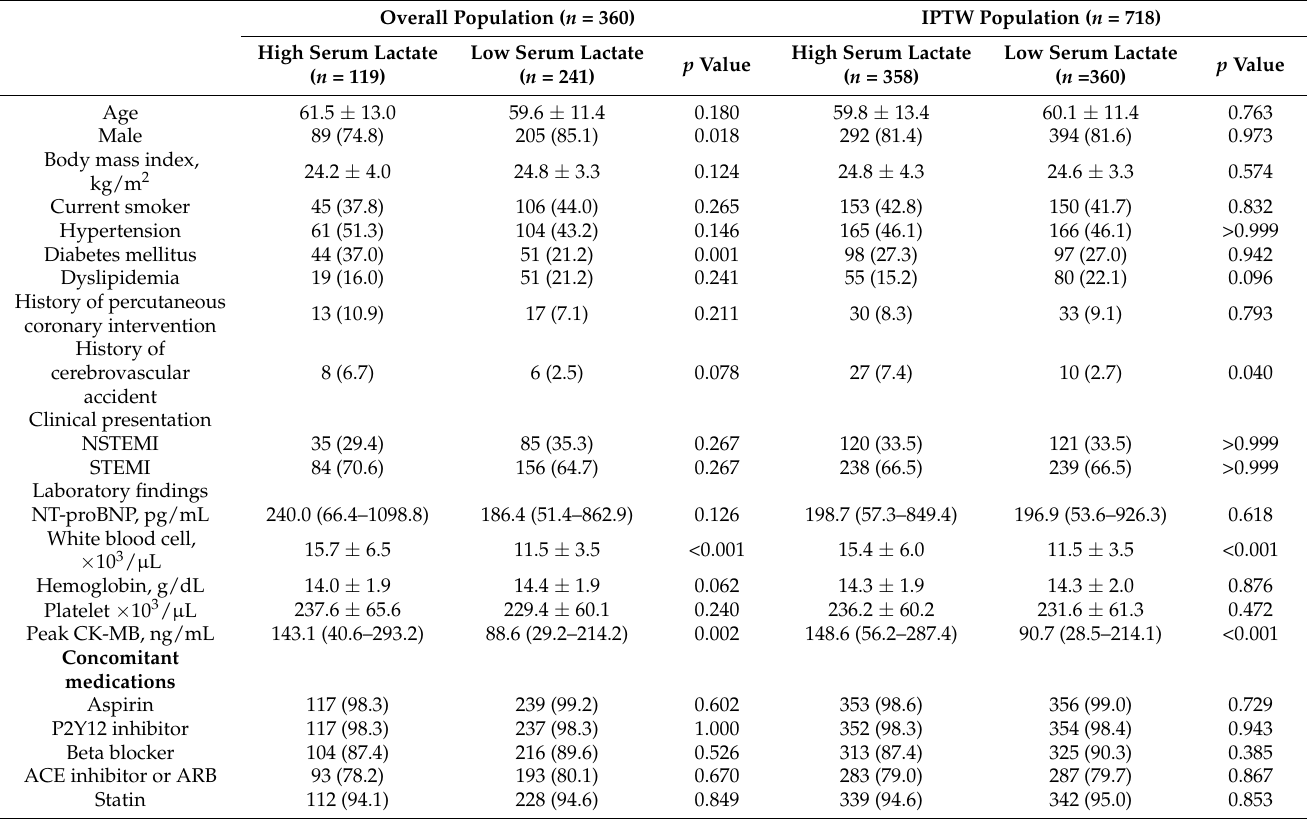
Table 1. Baseline